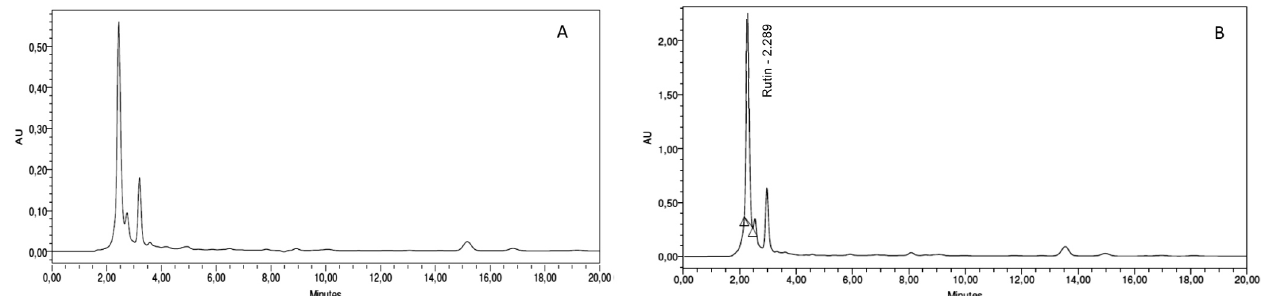
FIGURE 1 - Chromatograms of the ethanolic extract of Alpinia purpurata (EEAP). In A, the concentration of EEAP was 5 mg mL -1 ; in B, the concentration of EEAP was 5 mg mL -1 + 0.048 mg mL -1 rutin. Solvent: MeOH:H